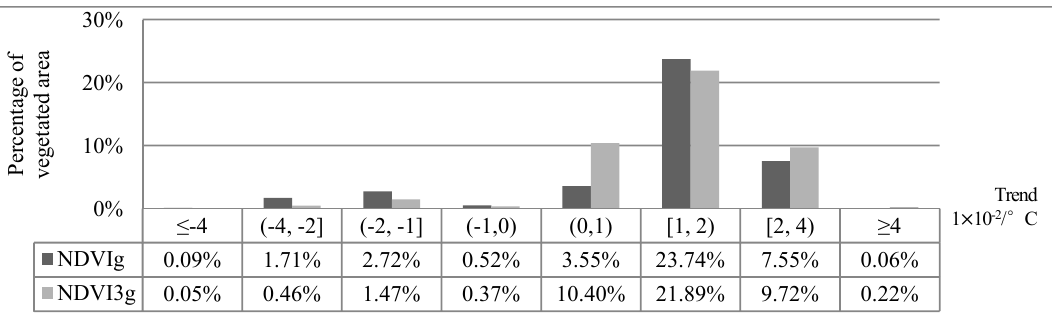
Figure 9. Frequency distribution for the response of growing-season NDVI to temperature change ( P < 0.05) derived from different NDVI data